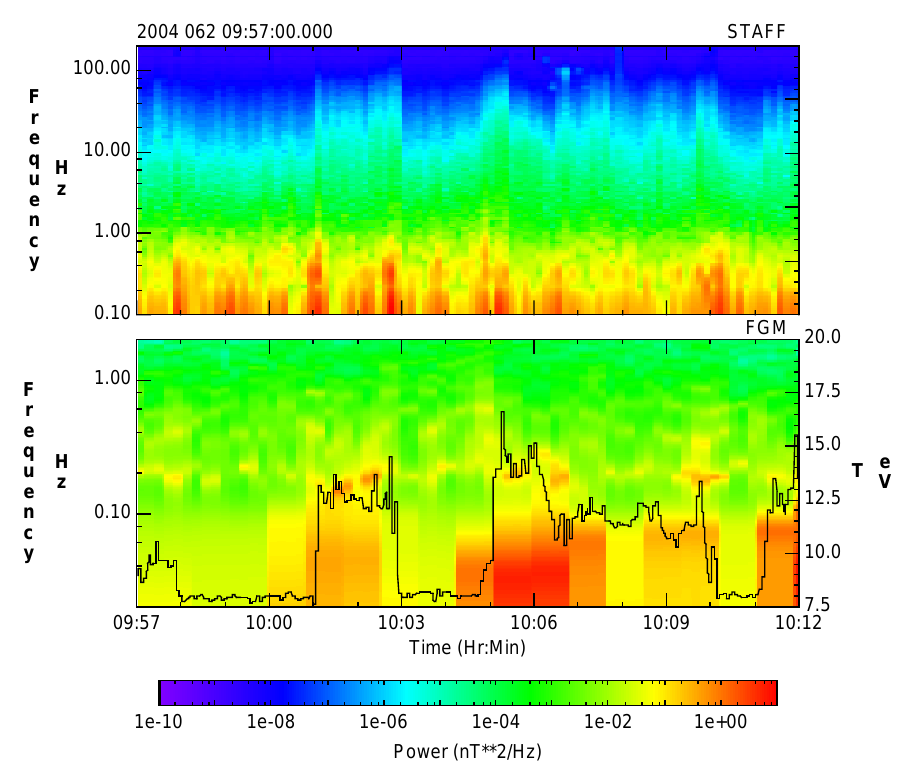
Fig. 7. Dynamic power spectrograms from STAFF (upper panel) and FGM (lower panel) over a time period that includes the interval shown in Fig. 6. The electron temperature is over-plotted in the lower panel. There is increased wave power in the foreshock especially at the lower frequencies. Puzzling is the lack of any coherent wave signature outside the foreshock where the scattering is